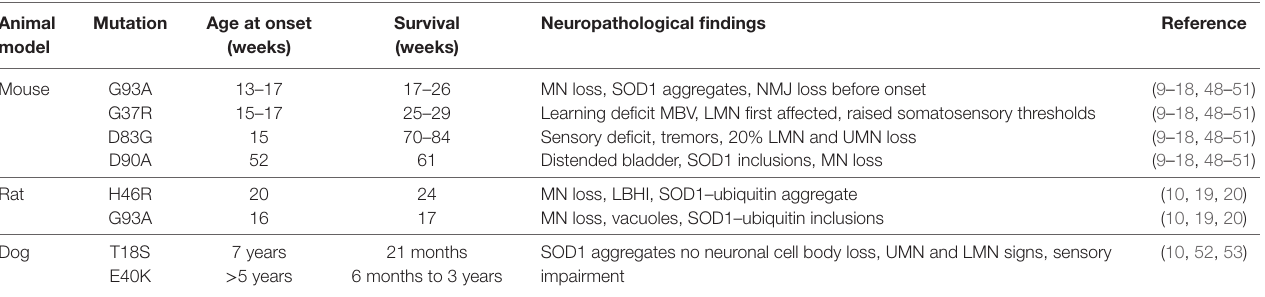
TABLe 2 | Characteristics of genetic mutations tested in various animal models. Animal model